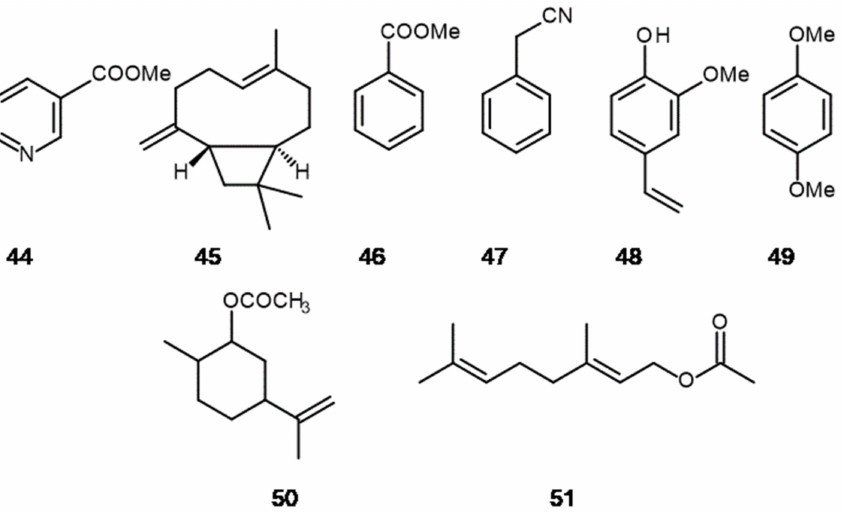
Figure 7. Structures of some allelopathic compounds: ( 44 ) methyl nicotinate, ( 45 ) β - cariophyllene, ( 46 ) methyl benzoate, ( 47 ) phenylacetonitrile, ( 48 ) 2-methoxy-4-vinylphenol, ( 49 ) 1,4- dimethoxybenzene, ( 50 ) dihydrocarveol acetate, ( 51 ) geranyl acetate. Among the common role of scent, namely positively affects pollinators and seed fitness [119], there are reverse trend in Nature, too. Sometimes fragrant scent (e.g.,